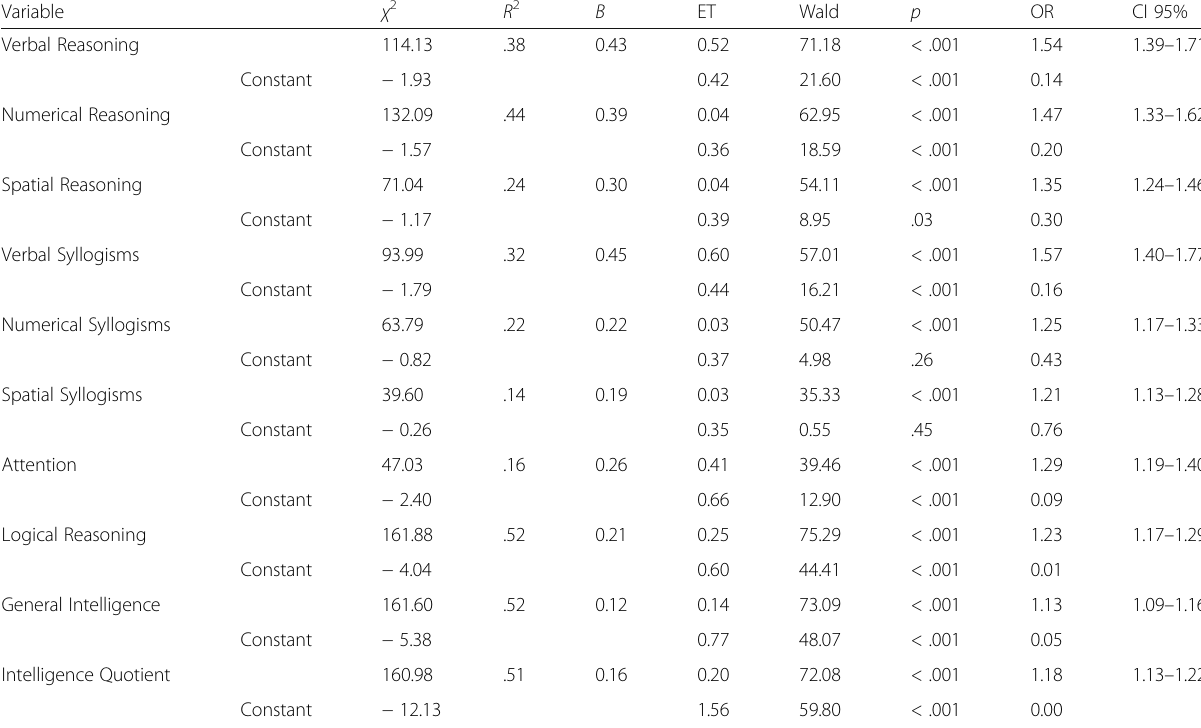
Table 3 Logistic regression for the predictive probability of each one of the cognitive aptitudes of the BADYG-E2 regarding the potential for no repeating the course